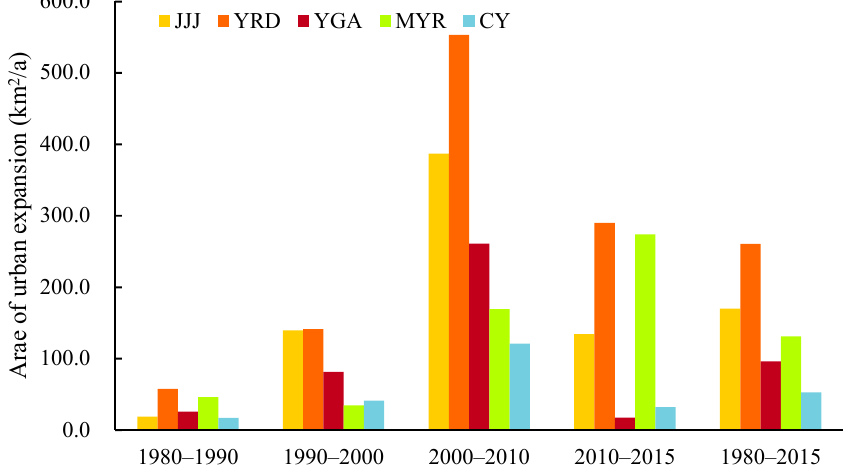
Figure 5. Regional divergence of the urban land expansion.